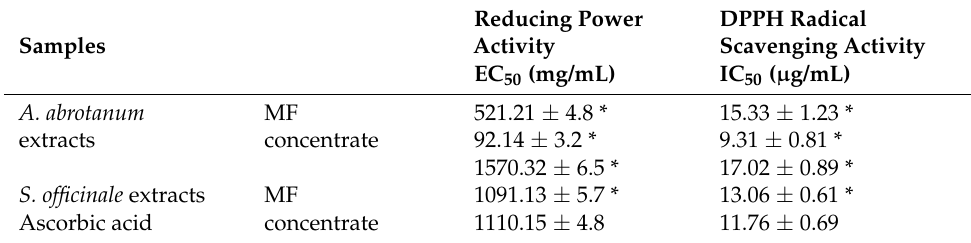
Table 3. Antioxidant activity of